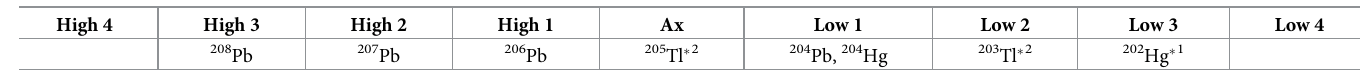
Table 6. Cup configuration for whole-rock isotope measurement.